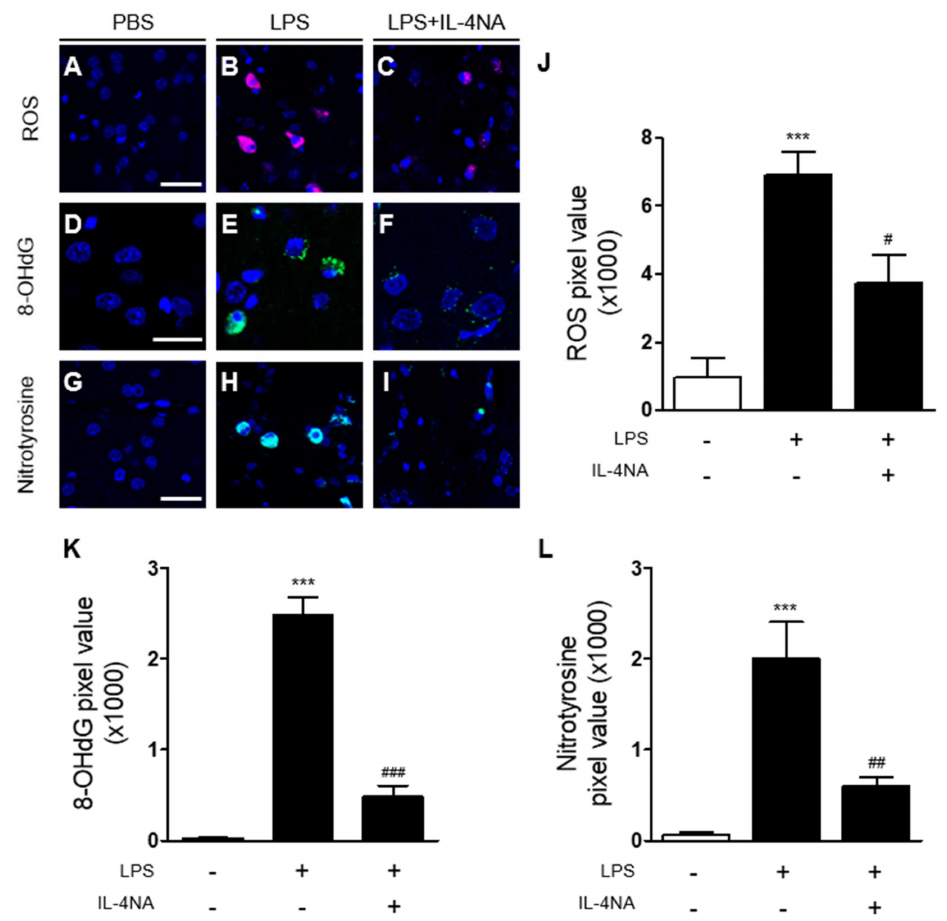
Figure 5. IL-4 induces oxidative/nitrosative stress in the LPS-injected striatum in vivo. Sections adjacent to those used in Figure 4 were prepared for immunohistochemical staining or hydroethi- dine histochemistry. ( A – C ) Hydroethidine histochemistry to detect oxidant production (ethidium fluorescence, red) in the striatum. Nuclei were counterstained with DAPI (blue). Scale bar, 30 µ m. ( D – F ) Immunofluorescence images of 8-OHdG (green) to detect oxidative DNA damage in the stria- tum. Scale bar, 20 µ m. Nuclei were counterstained with DAPI (blue). ( G – I ) Immunofluorescence images of nitrotyrosine (green) to detect nitrosative damage in the striatum. Nuclei were coun- terstained with DAPI (blue). Scale bar, 30 µ m. ( J ) Quantification of ROS expression *** p < 0.001, significantly different from PBS. # p < 0.05, significantly different from LPS. Mean ± SEM; n of animals = 4 in each group. ANOVA and Bonferroni analysis. ( K ) Quantification of 8-OHdG ex- pression *** p < 0.001, significantly different from PBS. ### p < 0.001, significantly different from LPS. Mean ± SEM; n = 4 to 5 in each group. ANOVA and Bonferroni analysis. ( L ) Quantification of nitrotyrosine expression. *** p < 0.001, significantly different from PBS. ## p < 0.01, significantly different from LPS. Mean ± SEM; n of animals = 5 in each group. ANOVA and Bonferroni